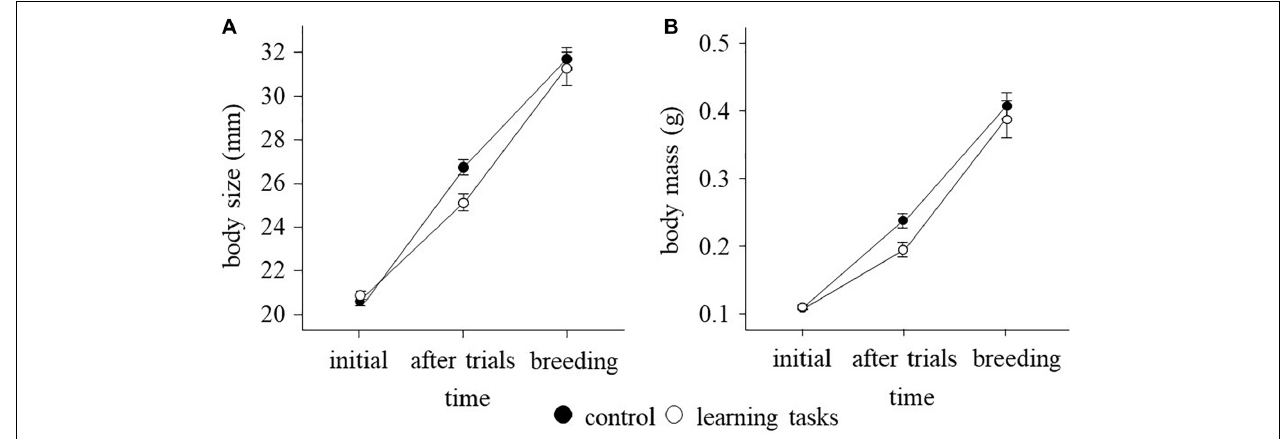
FIGURE 2 | Mean ± S.E. (A) body size and (B) body mass of sticklebacks measured in three time points, before the experiment (September, n = 264), after the learning experiment (January, n = 176) and at the beginning of the breeding season (March, n = 114) in the learning task (white dots) and control (black dots)